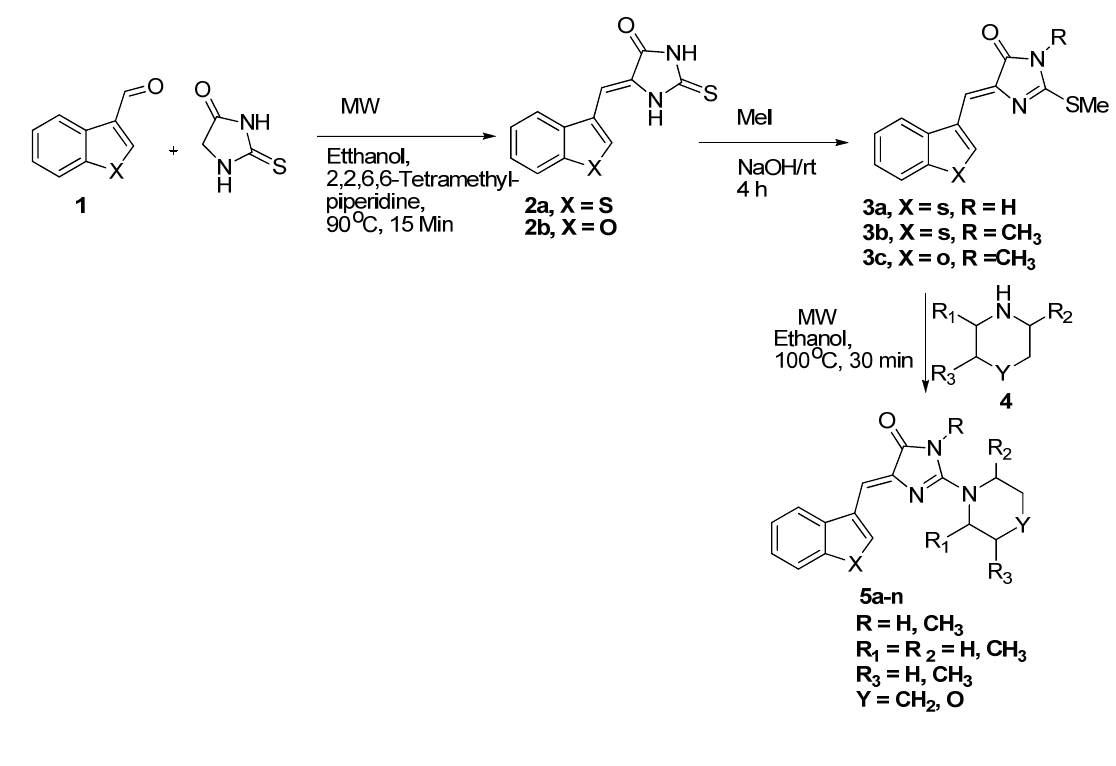
Scheme 1. Schematic representation for the synthesis of compounds 5a–n